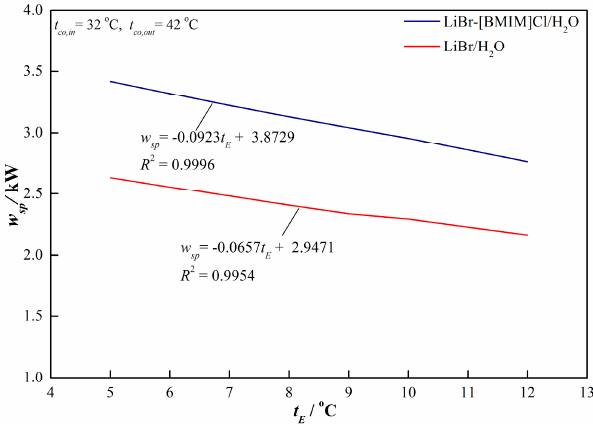
Figure 8. Variations of w sp with the evaporation temperature t E .